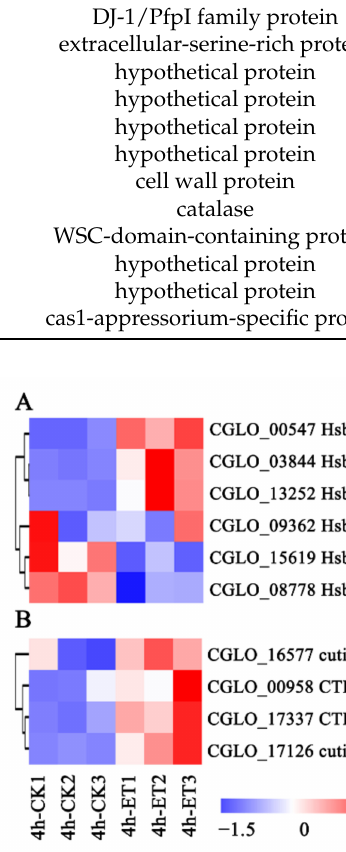
Figure 4. ET can significantly promote the expression of hydrophobic-surface-binding protein A genes and cutinase-related genes. ( A ) ET can significantly promote the upregulation of genes encoding for hydrophobic-surface-binding protein A (HsbA). ( B ) ET can significantly upregulate the expression levels of cutinase and its transcription factor (CTF1 α and CTF1 β ) genes. ( C ) In contrast to the WT and Cg-gfp control strains, ET can induce the expression of GFP driven by the promoters of the two HsbA genes in the P CGLO_03844 - gfp and P CGLO_13252 - gfp transgenic strains at 24 hpi after incubation on glass